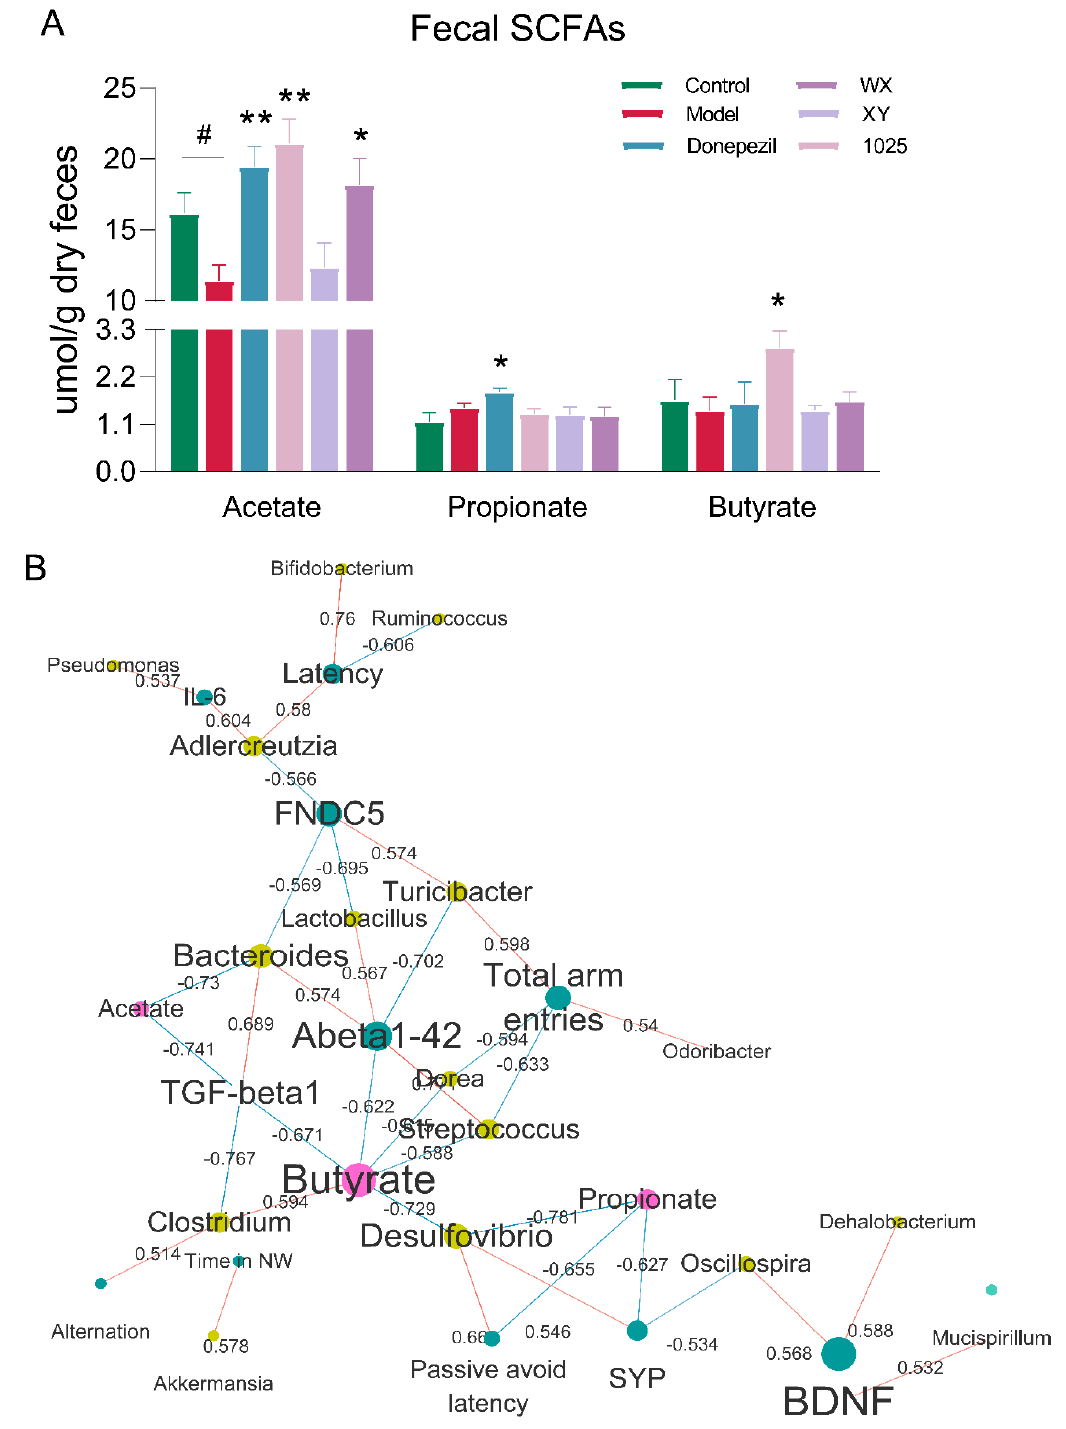
Figure 8. Alterations in microbial metabolites reveal potential mechanisms underlying AD. ( A ) The concentrations of SCFAs ( n = 6–8). Data are presented as mean ± standard error of the mean (mean ± SEM). Control vs. Model: # p < 0.05 by unpaired student’s t -test; * p < 0.05, ** p < 0.01 by one-way ANOVA. ( B ) Network representing significant and stability-selected correlations of cognition (blue nodes) with fecal microbial taxa at the genus level (yellow nodes) and fecal metabolites (red nodes). Red edges indicate a positive correlation and blue edges indicate a negative correlation, while the number on the edge indicates correlation. Note: SCFAs = short chain fatty acids, FNDC5 = fibronectin type III domain-containing protein 5, TGF = transforming growth factor , BDNF = brain-derived neurotrophic factor .